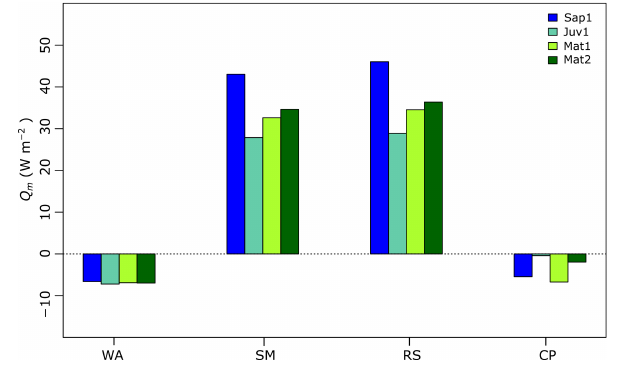
Figure 11. Available mean melting/freezing energy at our sites. WA denotes the winter accumulation period, SM the spring melting pe- riod, RS the rain-on-snow events, and CP events with low wind speed coinciding with smaller air temperature at site